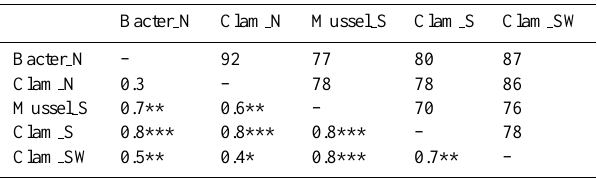
Table 4. Analysis of Similarity (ANOSIM; lower triangle), testing for significant differences in bacterial community structure between habitats and percentage of shared OTUs between habitats (upper triangle). ANOSIM R-values (lower triangle) are interpreted as fol- lows: R < 0 . 25=strongly overlapping, 0 . 25 < R < 0 . 5=separated but with overlap, 0 . 5 < R < 0 . 75=separated with only minor over- lap, R > 0 . 75=strongly separated. * p < 0 . 05, ** p < 0 . 01, *** < 0 . 001.